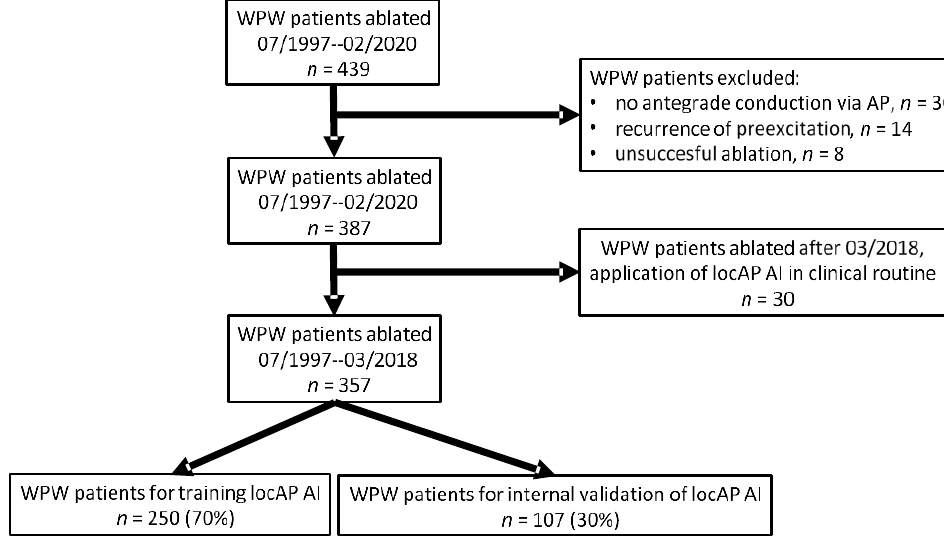
Figure 1. Flow chart of patients included in the present